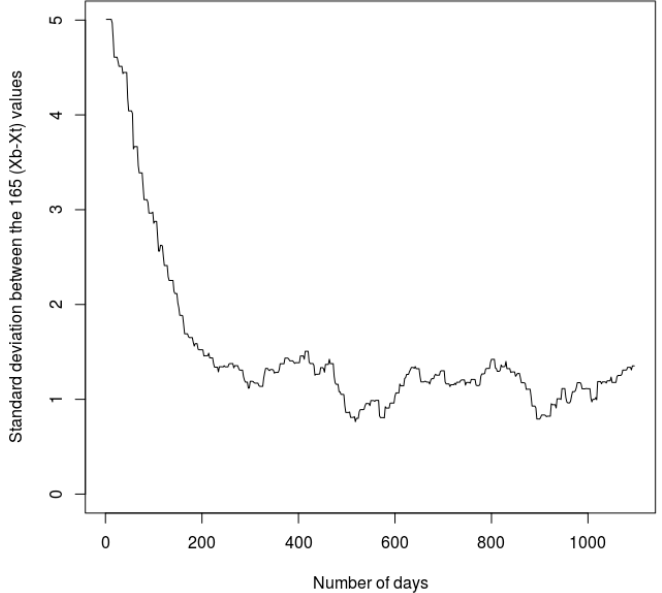
Figure 11. Temporal evolution of the standard deviation, σ , between the 165 (x b − x t ) terms, over the 1 August 1995–31 July 1998 period.